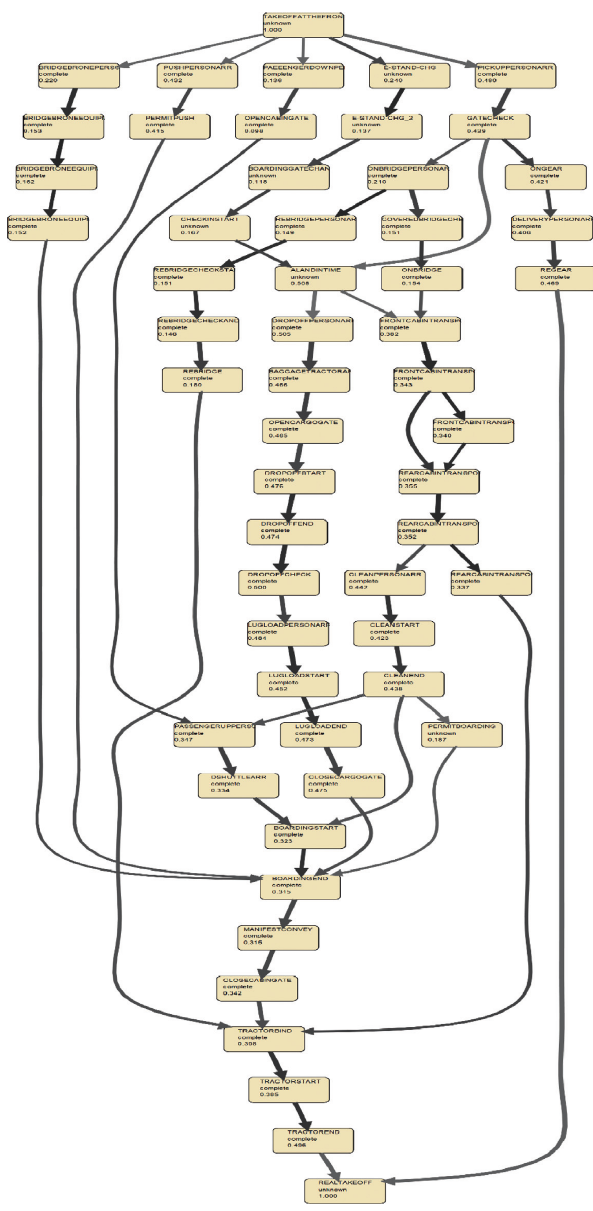
Figure 7: Process model of flight service.